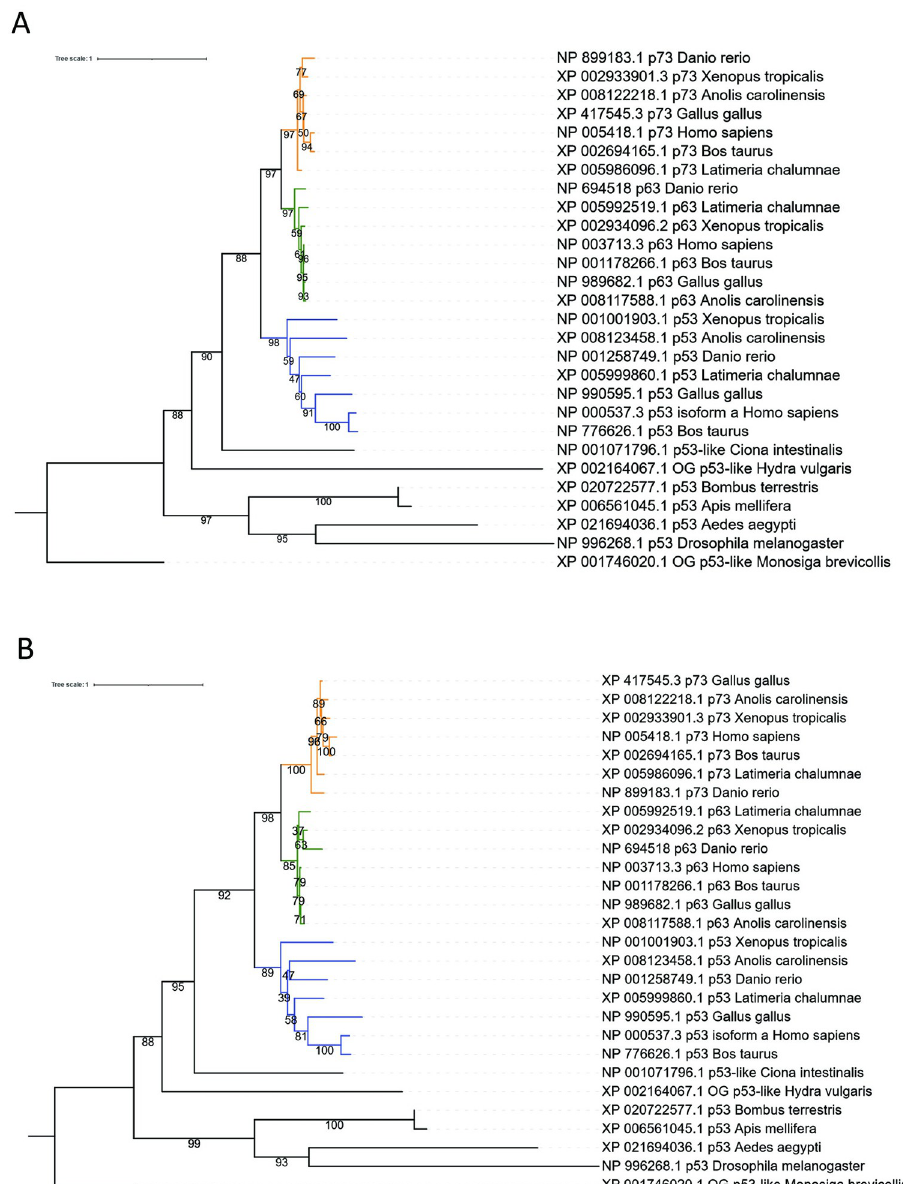
Fig 3. Phylogenetic trees of the P53 domain-containing proteins of metazoans using Neighbor Joining (A) and Maximum Likelihood (B). The trees were realized according to the model JTT+G [90], as calculated by ModelFinder [101], using the AIC [98]. The numbers on the internal edges/branches indicate the bootstrap values as calculated by the standard bootstrapping method [138] and UFBoot2 [131], respectively. The phylogenetic trees were inferred using MEGA 11 [55] and IQ-TREE 2 [77, 78], respectively, and the figures were generated using ITOL [153]. Green branches represent the p63 family, orange branches represent the p73 family and blue branches represent the p53